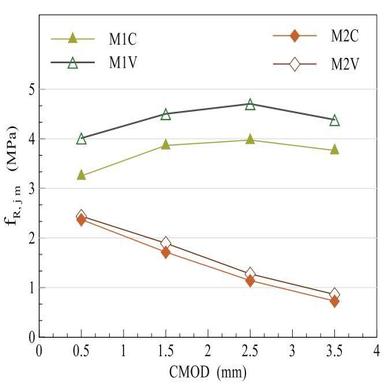
Residual flexural tensile strengths for mortars M1 and M2.